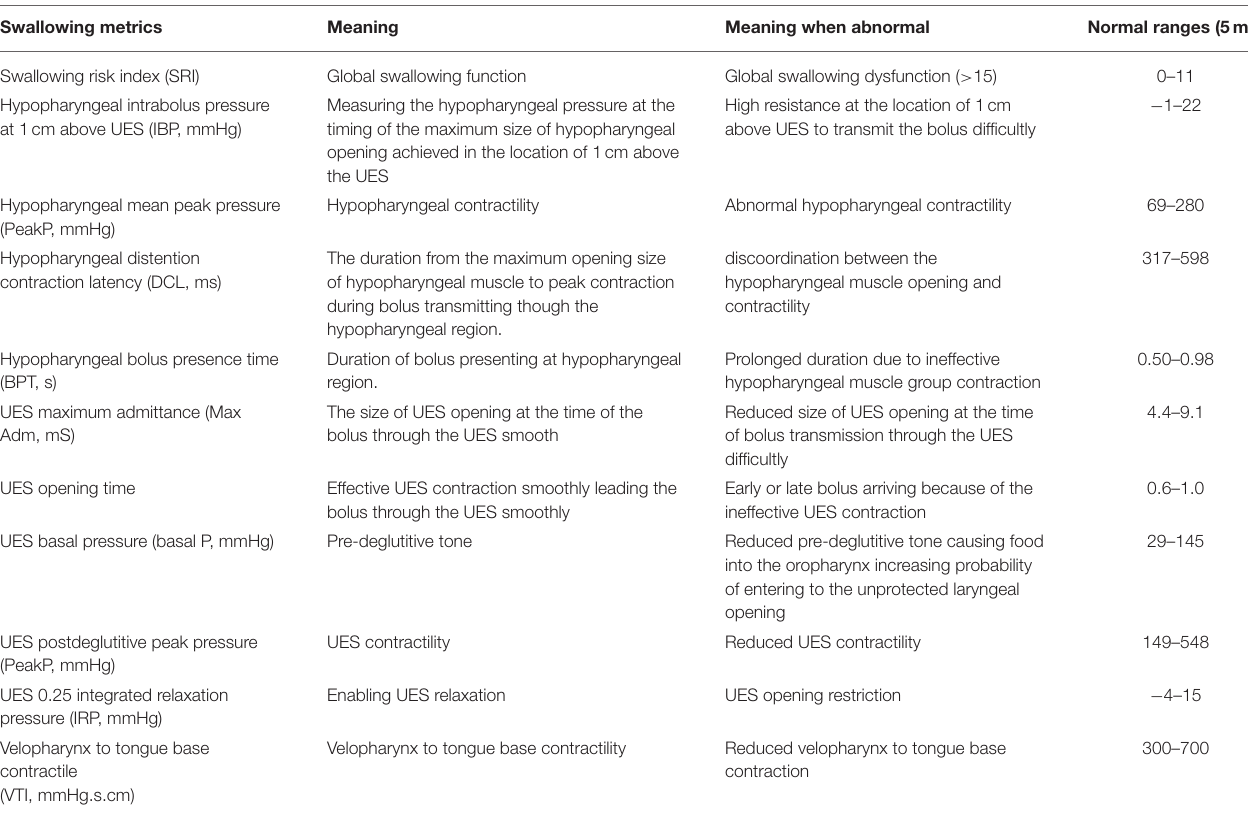
TABLE 1 | Normative values for novel swallowing